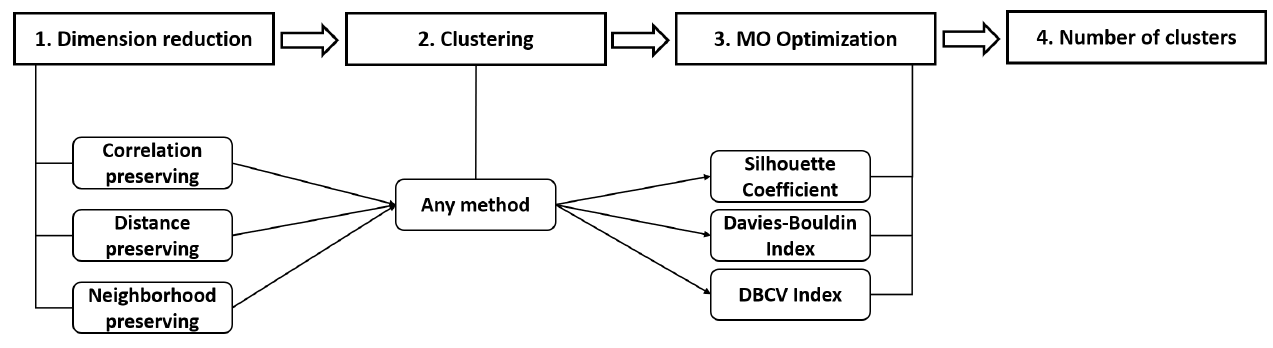
Figure 2. A step-wise summary of the proposed